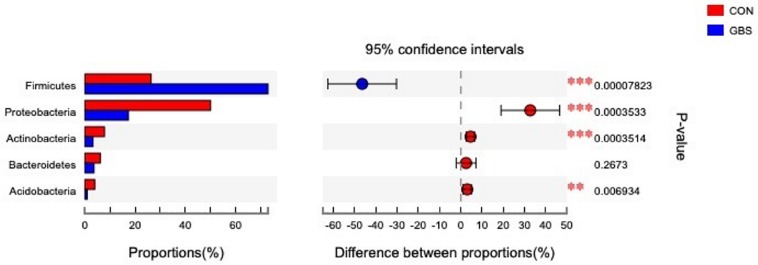
Differences between the relative abundances of five predominant bacterial phyla in milk samples from healthy cows (CON) and cows with S. agalactiae mastitis (GBS), n = 6. The extended error bar plot was generated using STAMP software. Welch’s two-sided test was used, and Welch’s inverted test was 0.95.